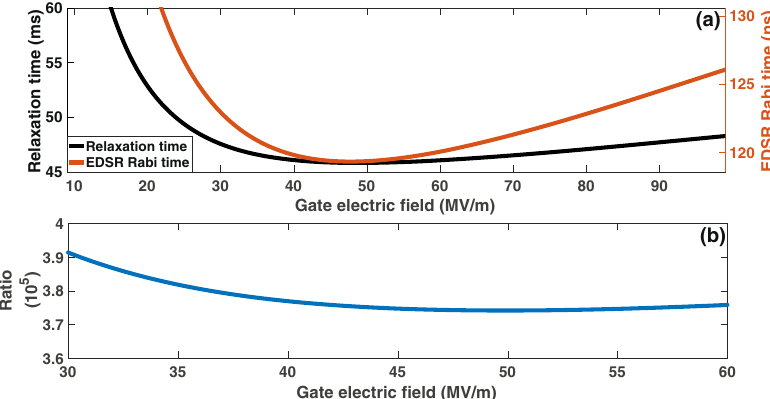
Fig. 4 The relaxation time and the EDSR Rabi time. In all plots d = 11 nm, a 0 = 50 nm, the external magnetic fi eld is B = 0.1 T. The density of Ge ρ = 5.33 × 10 3 kg/m 3 . The phonon propagation speed along the transverse direction is v t = 3.57 × 10 3 m/s, along the longitudinal direction it is v l = 4.85 × 10 3 m/s. a Relaxation time and EDSR Rabi time as a function of the gate electric fi eld. b The allowable number of single-qubit operations in one relaxation